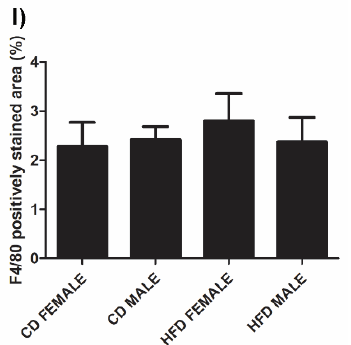
Figure 5. Histology and immunohistochemistry of liver tissues. Histology of liver sections harvested from CD females, ( A ); CD males, ( B ); HFD females, ( C ); and HFD males, ( D ). Microvesicular steatosis (black arrow) characterized by the accumulation of lipid droplets in the hepatocytes (h) was evident in the HFD animals ( C , D ), more prominently in the HFD males ( D ) with larger lipid vacuoles (white arrow) present. F4/80+ immunostained sections from the CD females, ( E ); CD males, ( F ); HFD females, ( G ); and HFD males, ( H ); showed positive staining (black arrow) in all groups, with no significant difference being observed; ( I ). Mean ± SD. Scale bar: 100 µm .